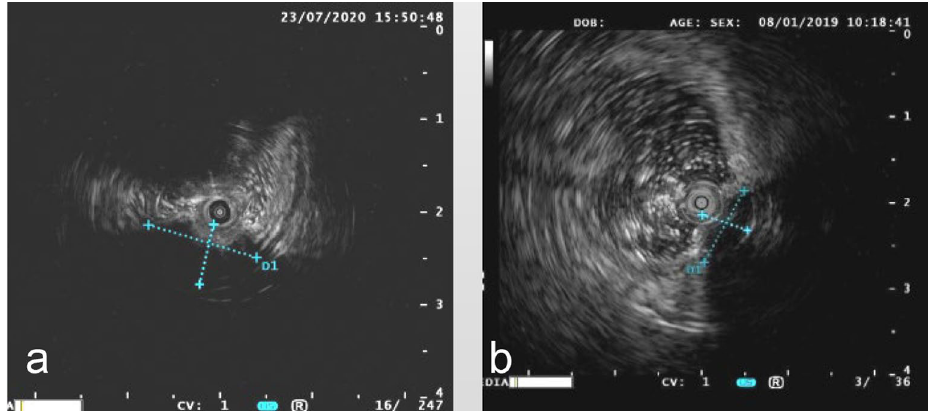
Figure 2. Colonoscopic ultrasound. ( a ) A hypoechoic mass is observed in the submucosa, which was demarcated from the muscularis propria. ( b ) A hypoechoic mass in the submucosa that is poorly demarcated from the muscularis propria.